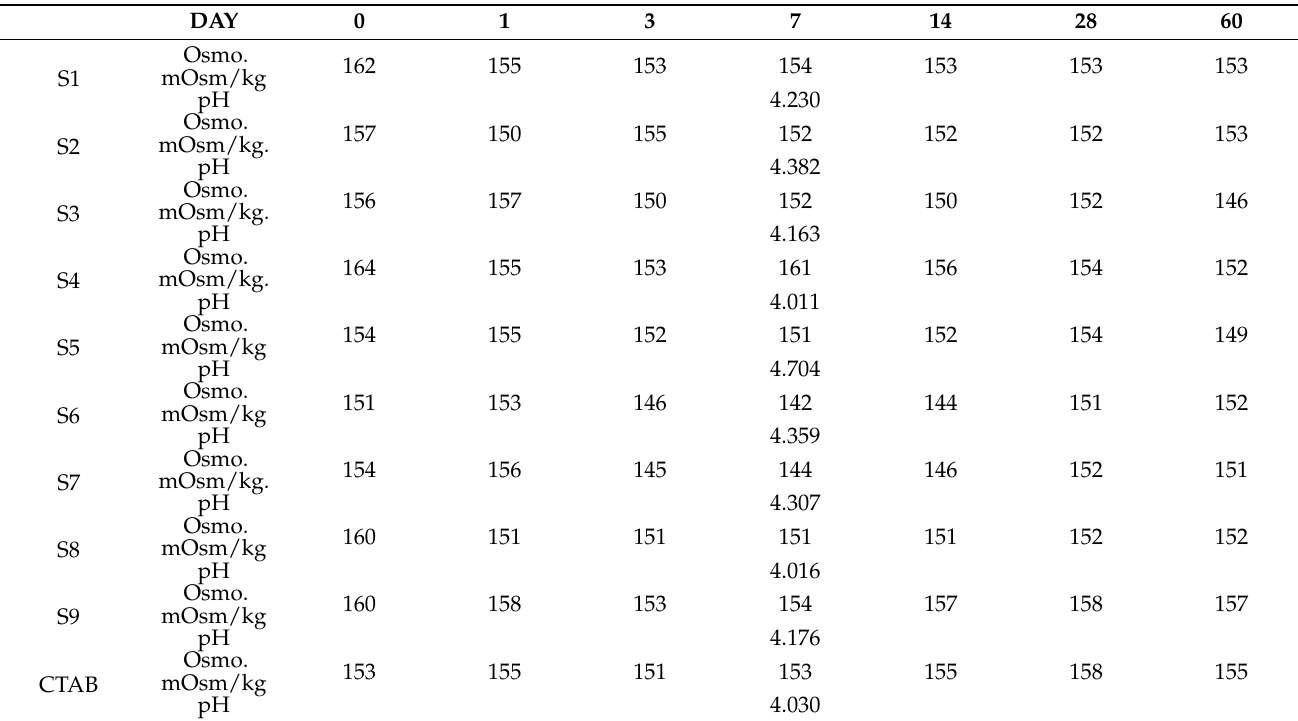
Table 5. Osmolality (mOsm/kg) of NEs monitored over a period of 60 days stored at 4 ◦ C. The pH values were recorded on the day of production (day